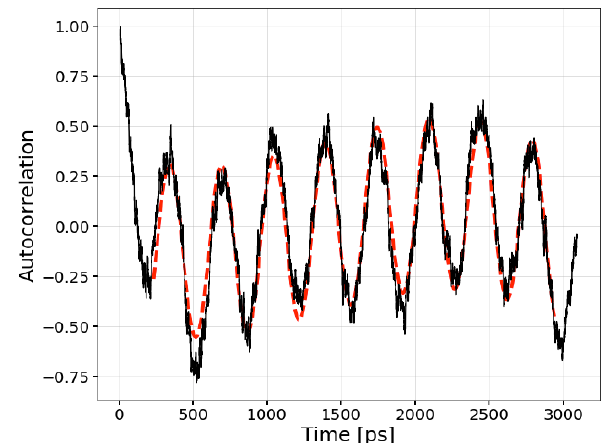
Fig. 10. Bunch structure as measured by the fast Silicon detector. For the first time, we were able to measure the structure in timescales of about 50 ps that allow to measure and control instantaneous doses delivered to